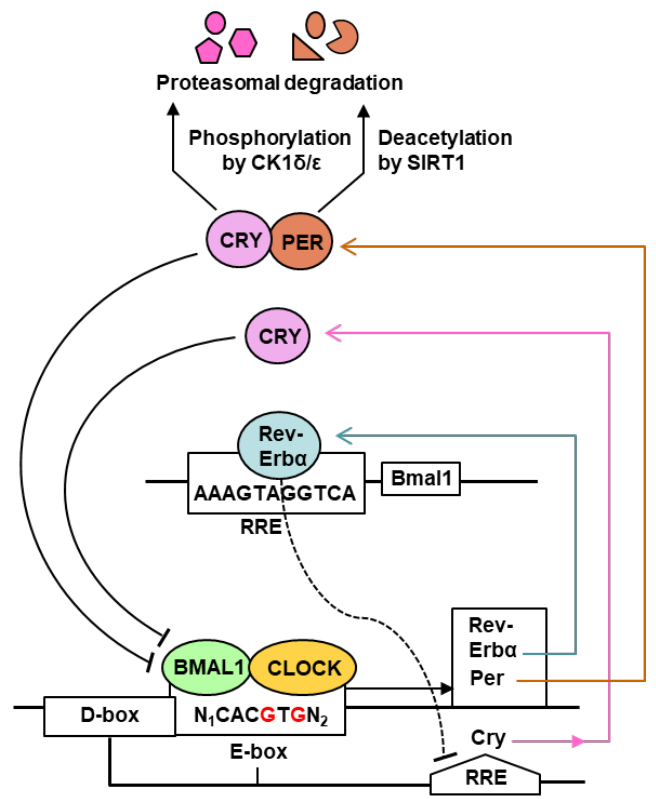
Figure 1. Feedback loops (TTFLs) of the mammalian circadian clock. This is a simplified snapshot